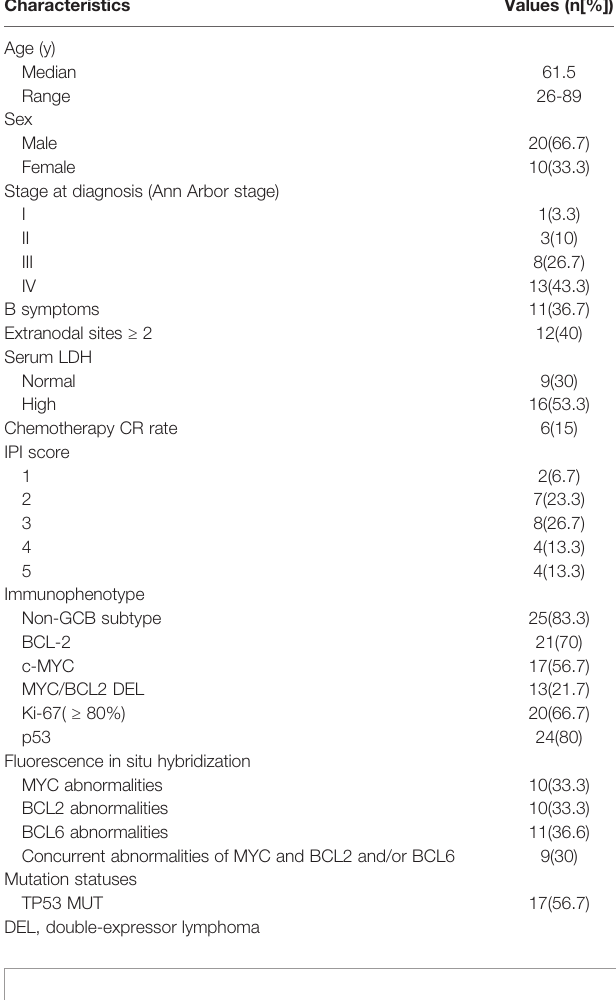
TABLE 1 | Clinical Features of the 30 Patients With ADLBCL. Characteristics